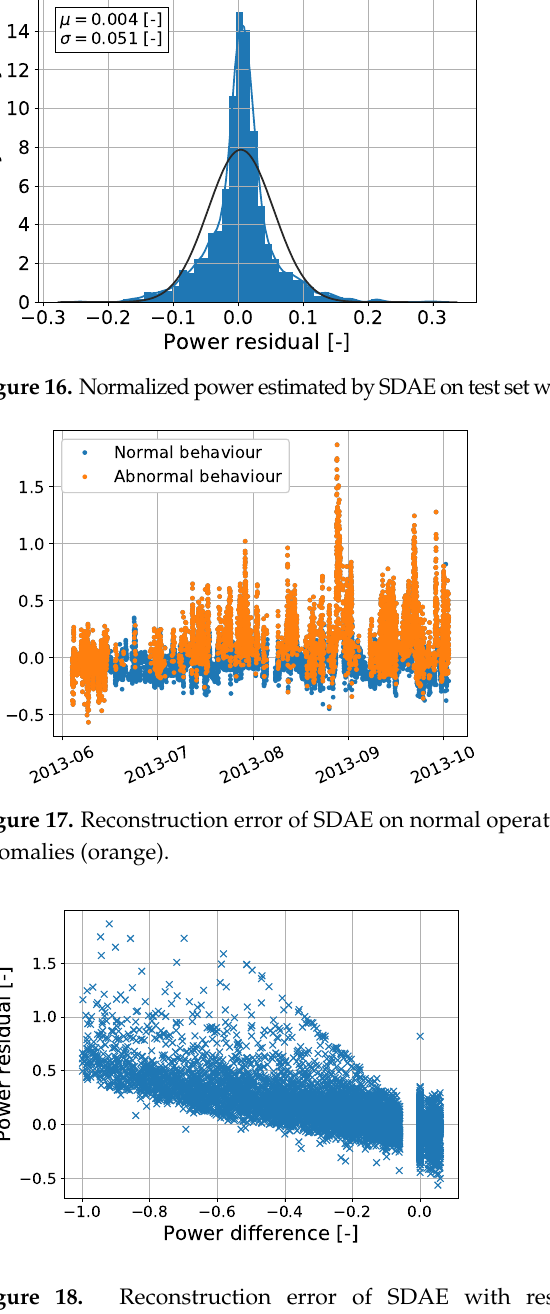
Figure 18. Reconstruction error of SDAE with respect to normalized power deviation P abnormal − P normal